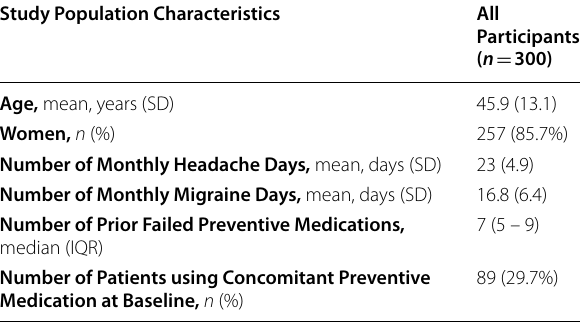
All patients were diagnosed with chronic migraine without medication overuse headache. Abbreviations: SD standard deviation, IQR interquartile